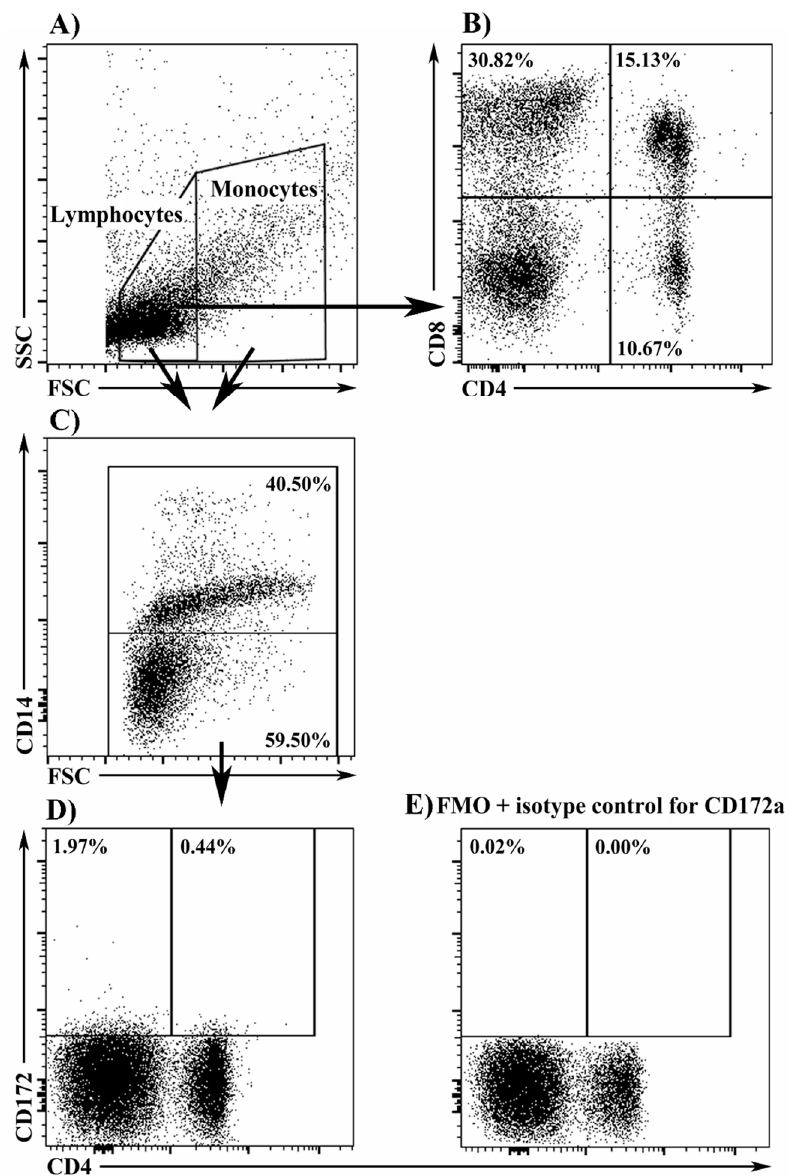
Figure 3. ( A ) The entire PBMC population was gated and a lymphocyte gate was set in the FSC vs. SSC plot; ( B ) Lymphocytes expressing the analyzed antigens were isolated in the CD4 vs. CD8 plot; ( C ) CD14 + (monocytes) and CD14 − cells were isolated from PBMC in the FSC vs. CD14 plot; ( D ) cDC (CD172a high 4 − ) and pDC (CD172a dim 4 + ) were isolated in the CD4 vs. CD172a plot; ( E ) The Fluorescence Minus One ( FMO) plus isotype control for CD172a antibody was used to determine the gate for the CD172a + cells.